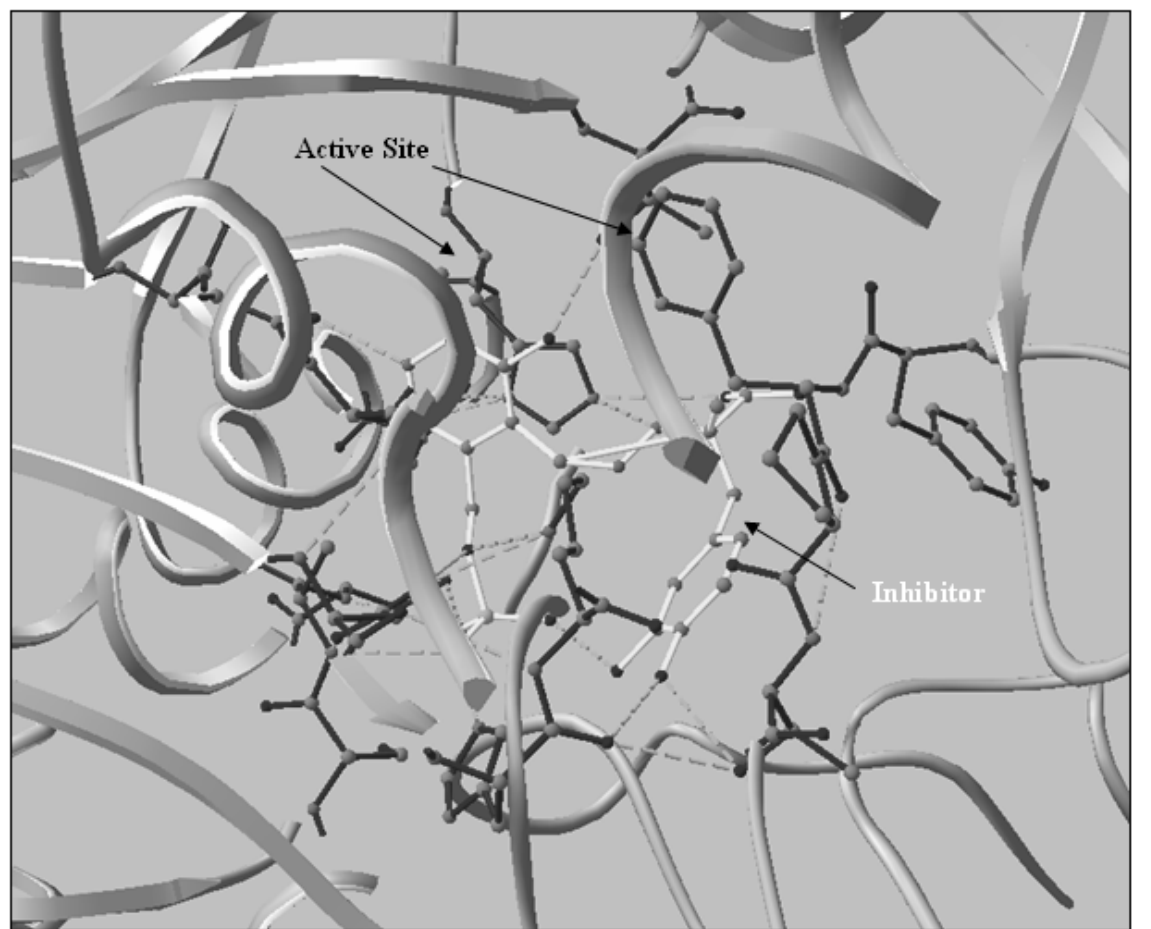
Figure 8: Crystal structure of DOPA decarboxylase in complex with the inhibitor carbidoba (chain A from the homo-dimer is shown). The residues of the active site (represented as "balls-and-sticks") bind the inhibitor (white) via hydrogen bonds. The residues of the active site of DOPA are found by detecting residues in a radius of possible H-bonds (3.6 angstrom) around the inhibitor molecule. The H-bonds are represented as doted